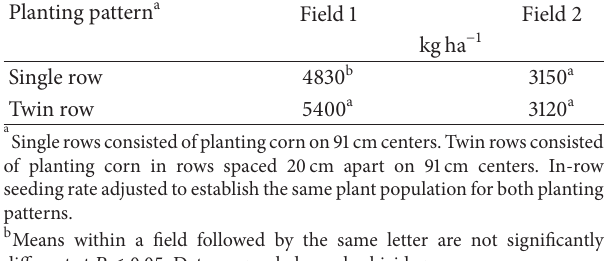
(Table 3). Similarly, applying POST herbicides increased the duration of silking compared with S -metolachlor alone (Table 3). The difference in silk emergence between fields 1 and 2 could not be